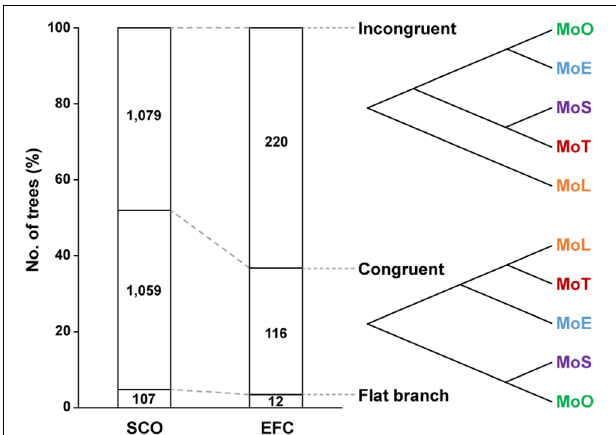
FIGURE 5 | Patterns of the evolution of the SCO and EFC genes. The phylogenetic trees built using the SCO and EFC genes are grouped into those that are incongruent ( d ≥ 0.5) with the phylogenomic tree ( Figure 1A ), those that are congruent ( d < 0.5) and those caused flat branch due to perfectly conserved sequences. An example of each case is